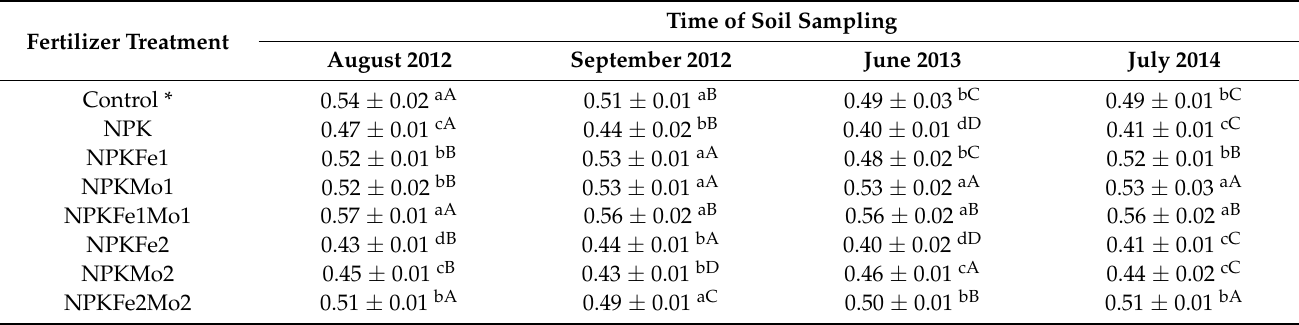
Fertilizer Treatment